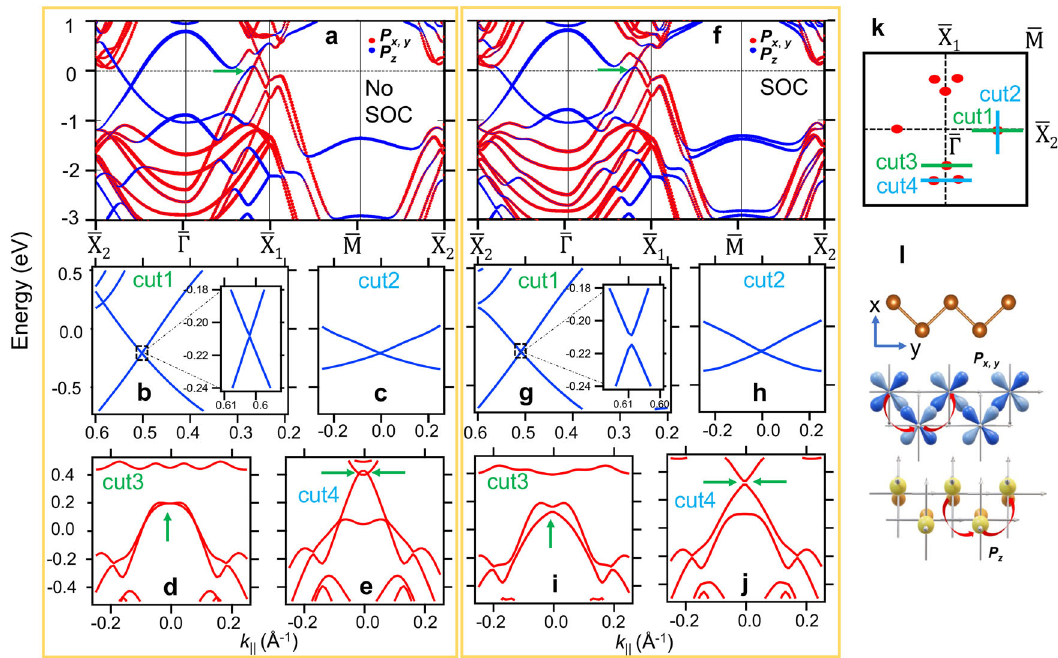
Fig. 4 | Calculated band structure of 2L α -Sb. a The band structure of 2L α -Sb arrows in d and e . f – j Same as a – e , but calculated with the inclusion of SOC. k The calculatedwithouttheinclusionofSOC. b – e Thecalculatedbanddispersionsalong Brillouin zone of 2L α -Sb. The Dirac points in the case without SOC are marked by ‘ cut1-4 ’ , respectively. The Dirac points in the direction of (cid:2) Γ - (cid:2) X red dots. l Schematic diagrams showing the formation of p x , y and p z 1 are markedby green